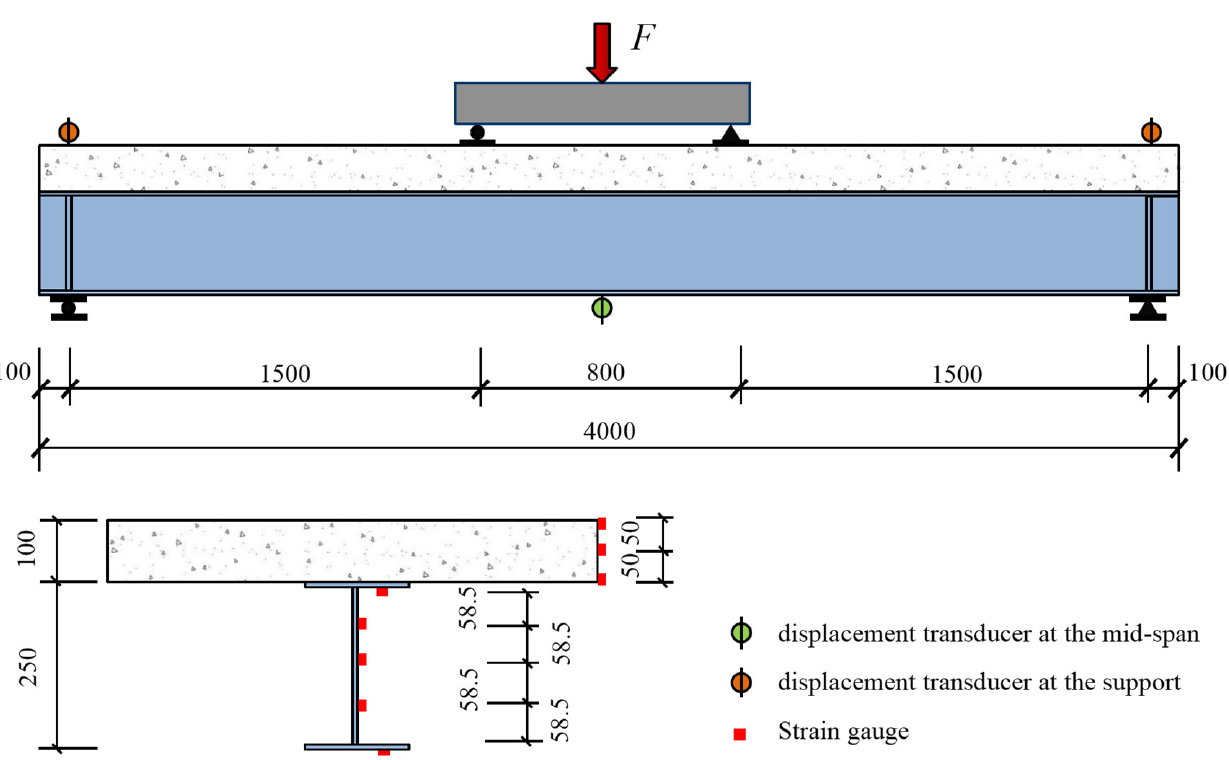
Figure 3. Measuring points arrangement.